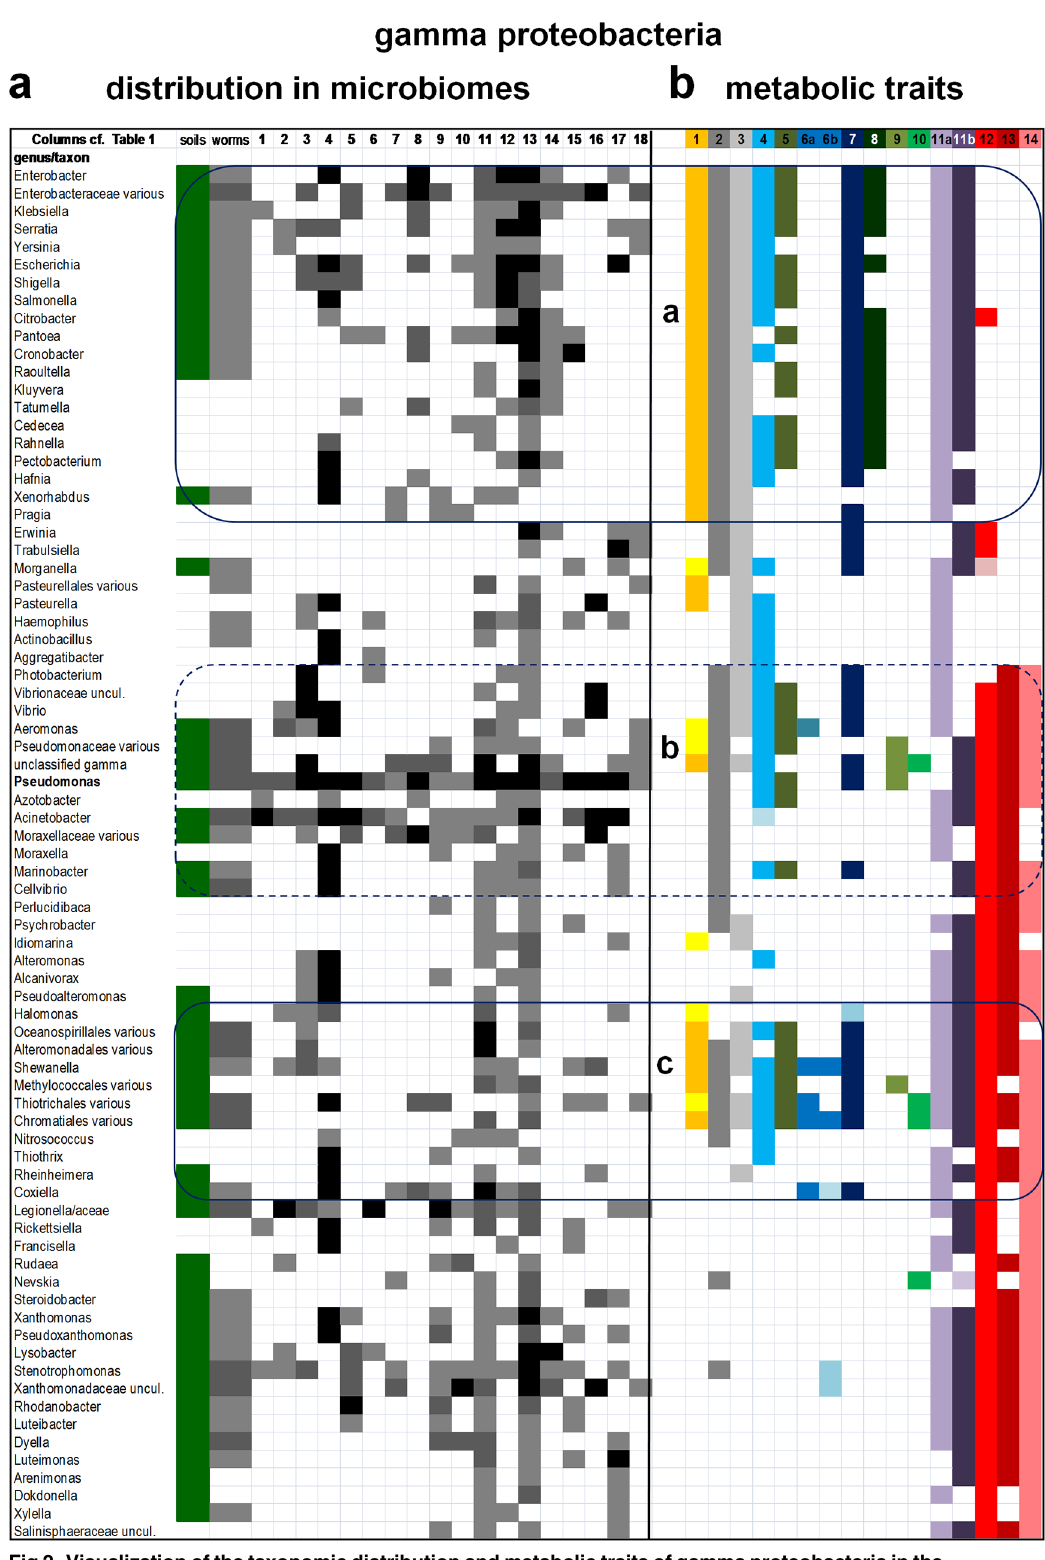
Fig 2. Visualization of the taxonomic distribution and metabolic traits of gamma proteobacteria in the microbiome of soils, C . elegans and 18 arthropods. Taxa of gamma proteobacteria in the microbiomeof soils and